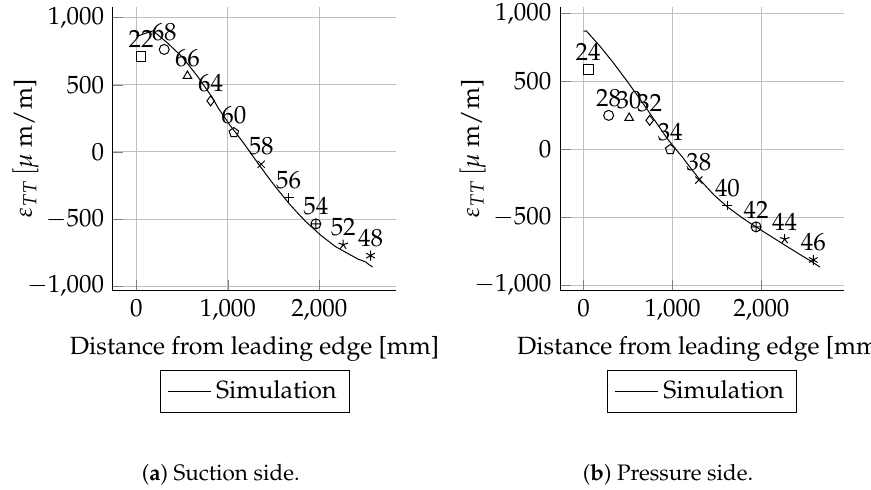
Figure A18. Strain comparison ε LL at radial position R = 5000 mm for Mxmin load case.